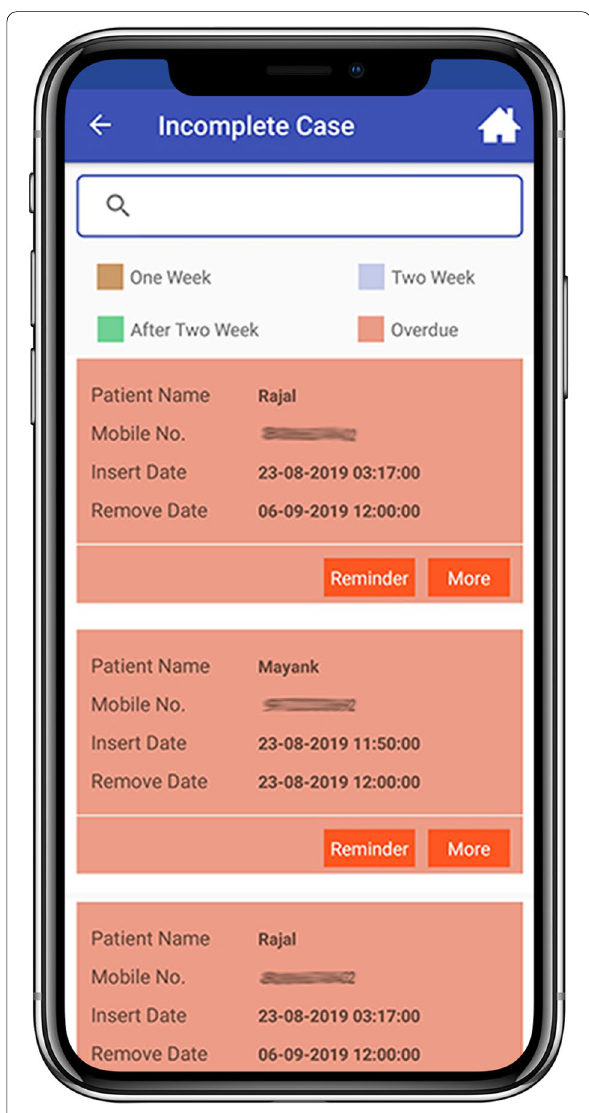
Fig. 4 Colour-coded representation of the incomplete